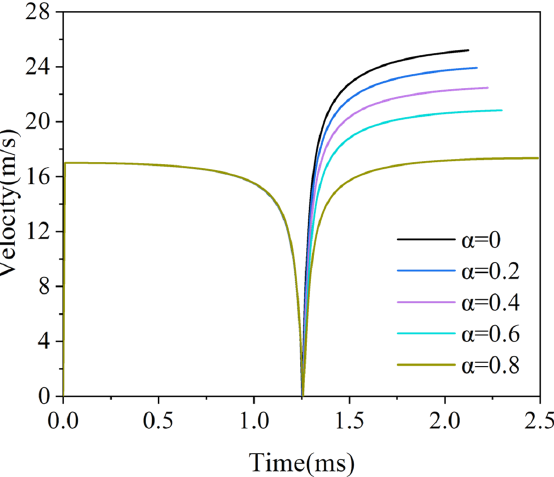
Figure 9. Variation curves of the piston velocity under different α .